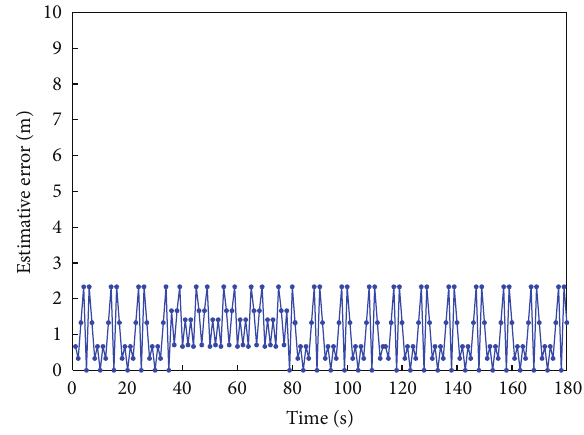
Figure 4: The estimation error for path 1